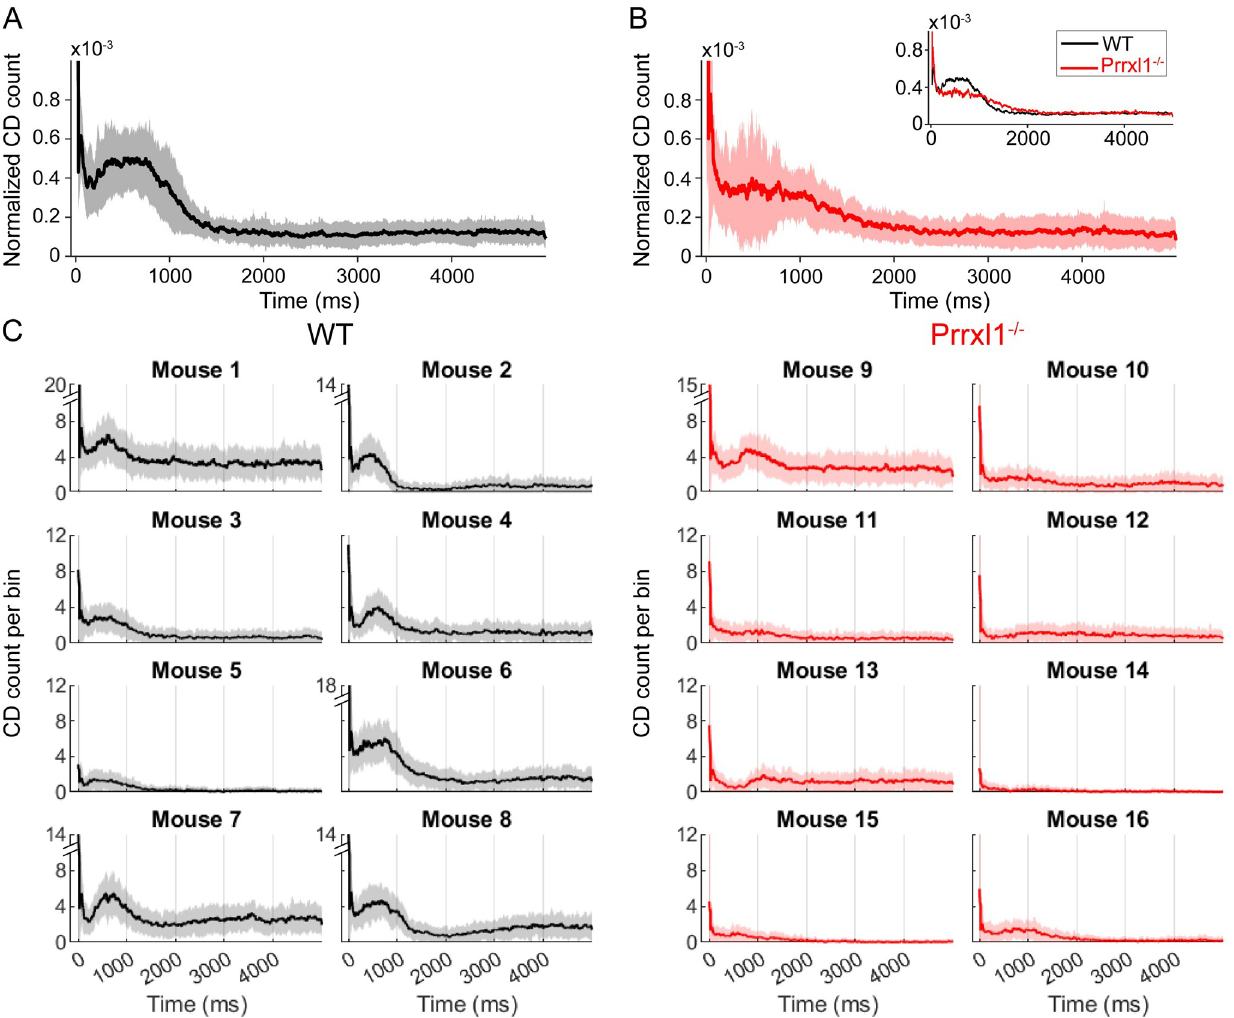
Fig 7. Time course of licking in WT (black and gray) and KO (red and pink) mice. (A) All wildtype mice showed a peak in licking behavior between 1–1000 msec after the water reward was dispensed. The black curve shows the mean of the CD histogram computed across all sessions and all days for all wildtype mice. Plus and minus standard deviation around the mean is shaded gray. (B) Prrxl1 –/– mice showed much more variable licking behavior. The red curve shows the mean of the CD histogram computed across all sessions and all days for all Prrxl1 –/– mice, with plus and minus standard deviation around the mean shaded light red. The inset overlays the mean CD counts for WT and KO animals. (C) All individual mice CD histograms with a bin size of 51ms. All y-axes go to 12 CD counts/bin unless labeled with an axis break, in which case the maximum y-value is labeled.